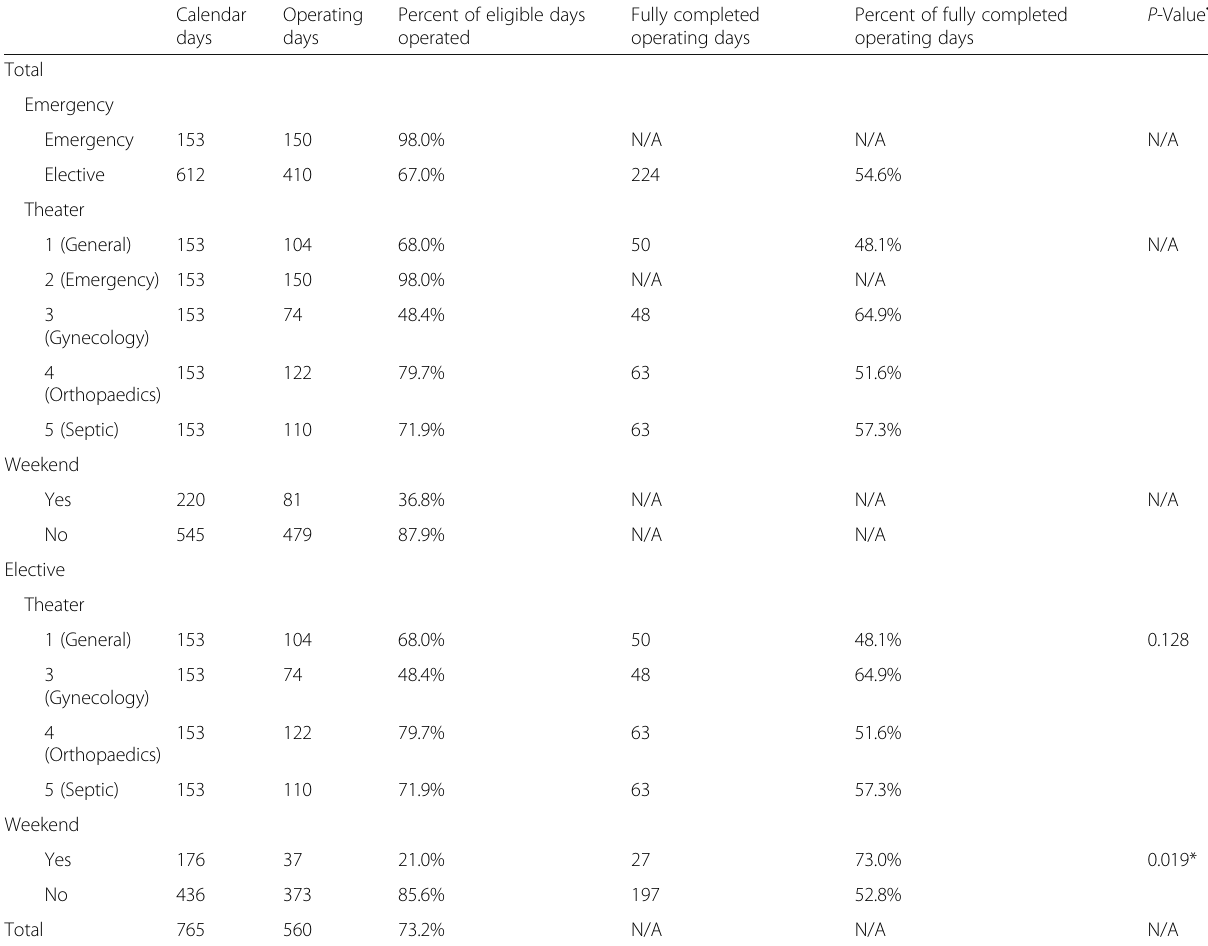
Table 3 Eligible operating days with